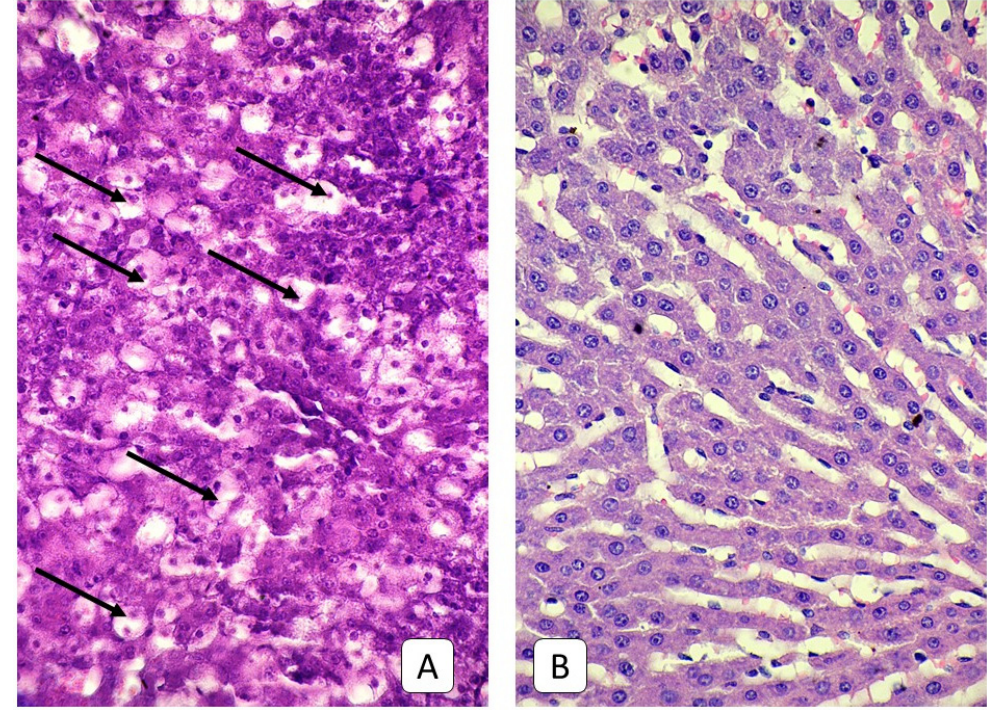
Figure 7. Photomicrograph of the liver. ( A ): juvenile rats, 7th day after mTBI. Dystrophic hepatocytes with swelling, light cytoplasm, pycnotic nuclei, and vacuoles (arrow). ( B ): control group. Liver parenchyma. H E, ×400.